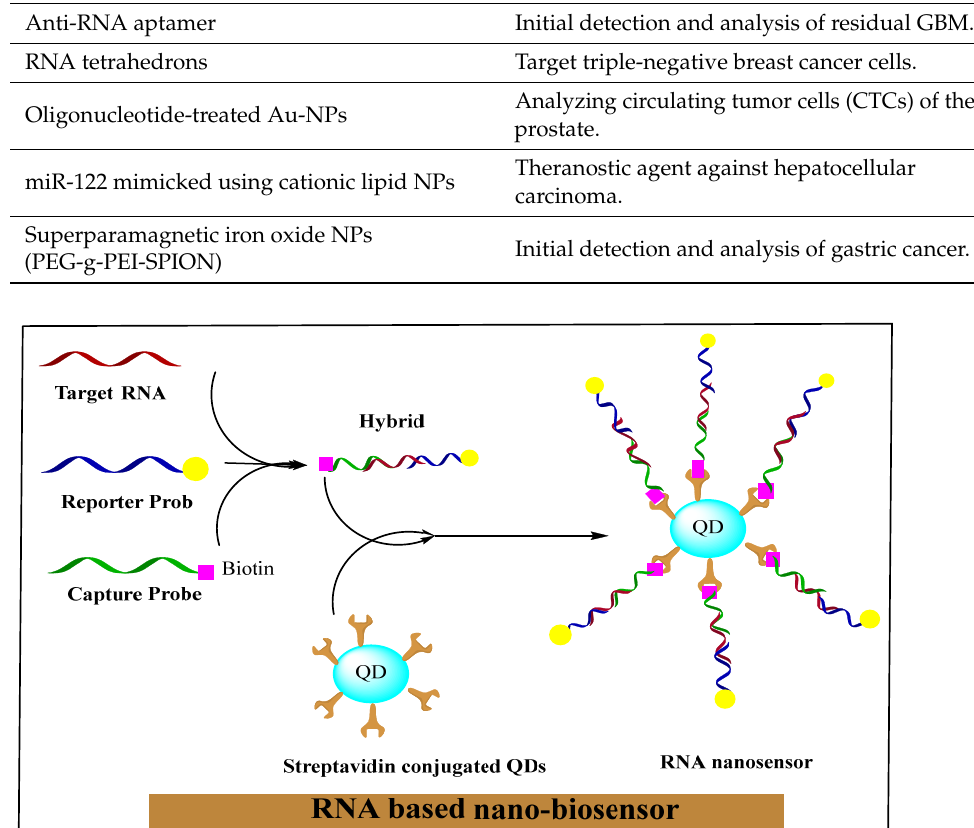
Figure 2. RNA-based nano-biosensor. Reprinted with permission from [75] . Copyright 2021 Elsevier.